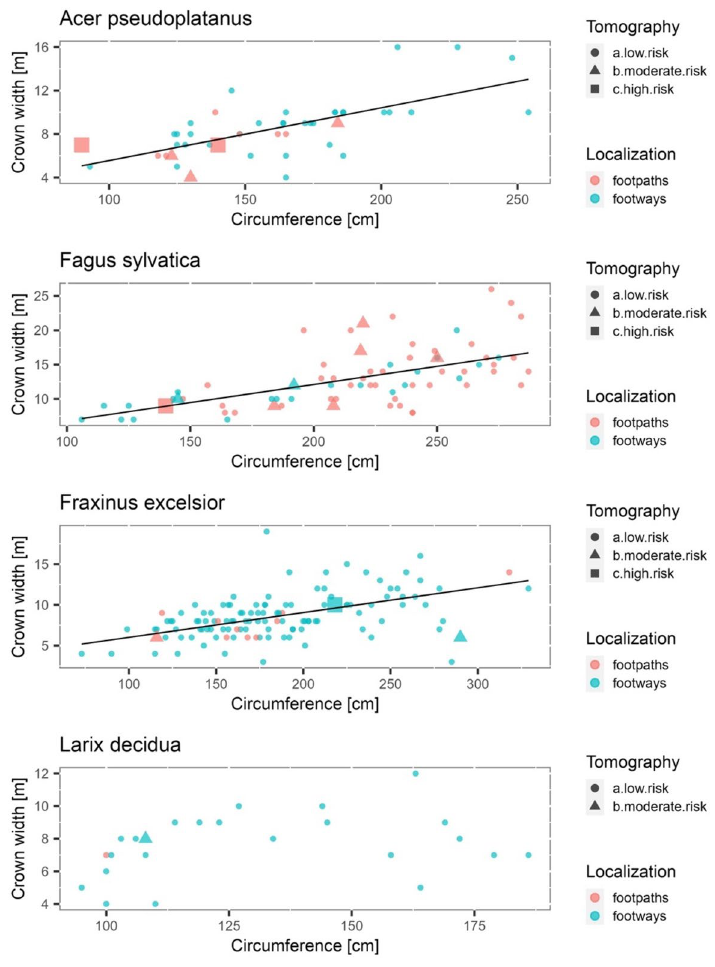
Figure 3. The relationship between tree size (crown width, circumference), tree location (footways along the streets, main footpaths in the park) and results from the tomography scan. The weighted regression line was added for each species. The line was not plotted for the Larix decidua because the dependence was non- significant. ( Source: Processed by the